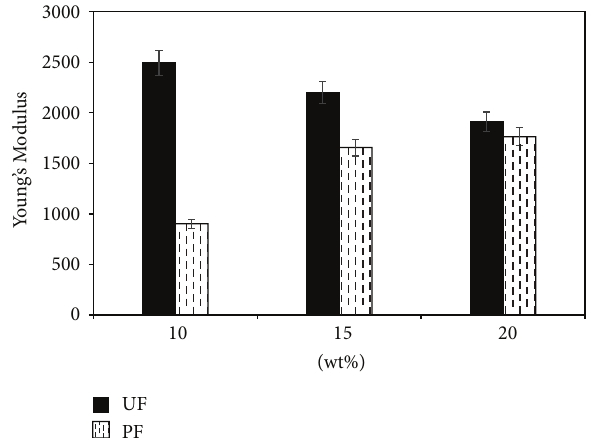
Figure2:Bendingstrengthofsagoparticleboardversusresinmatrix content (wt%).